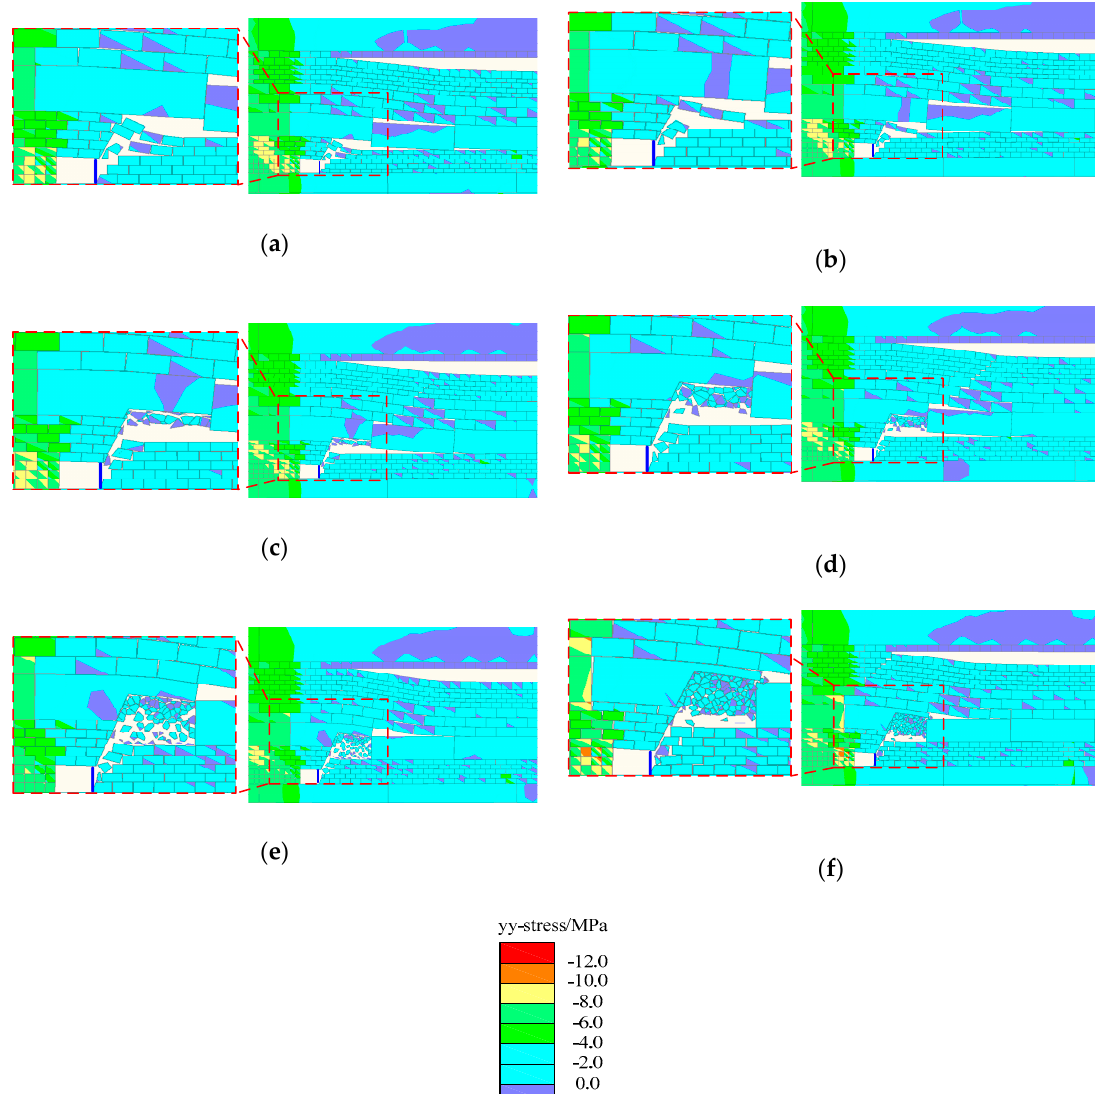
Figure 15. Numerical calculation results of vertical stress distributions for different cutting heights. ( a ) Cutting height 3 m; ( b ) Cutting height 4 m; ( c ) Cutting height 6 m; ( d ) Cutting height 7 m; ( e ) Cutting height 8 m; ( f ) Cutting height 9 m.